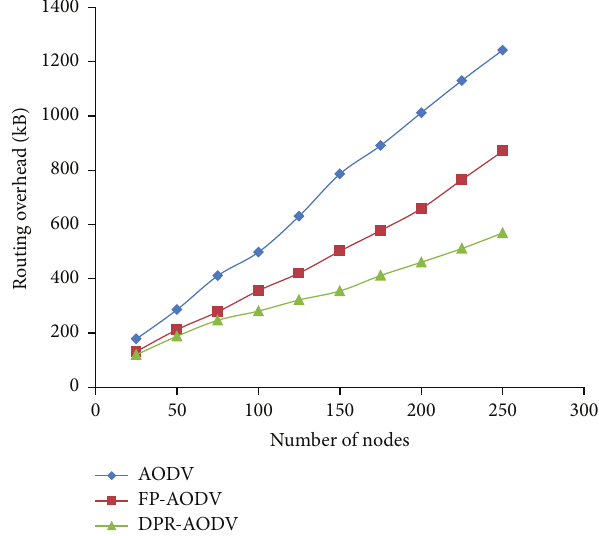
Figure 3: Overhead in bytes versus number of mobile